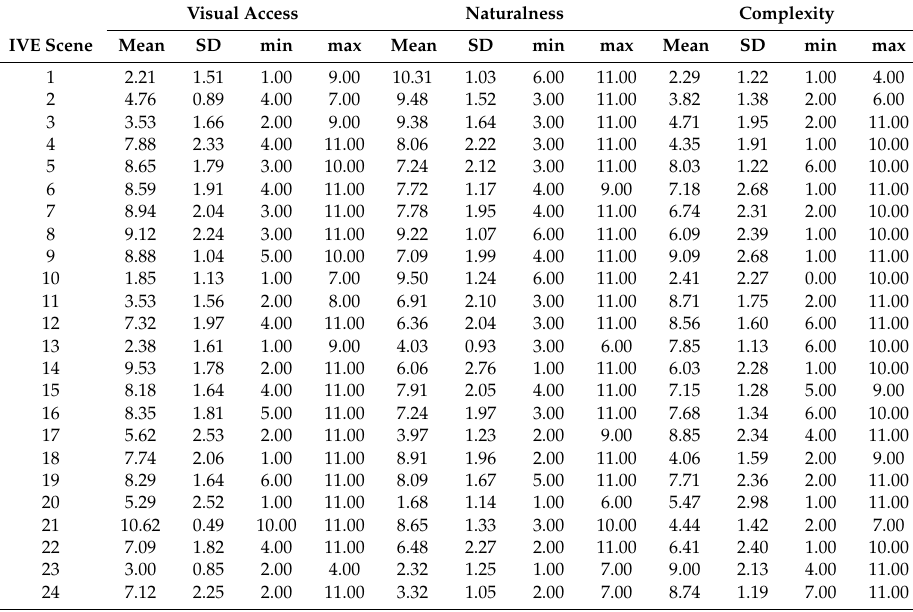
Descriptive statistic of participants ratings of perceived visual access ( n = 34), perceived naturalness ( n = 32) and perceived complexity ( n = 34) for the 24 IVE scenes used in the survey.